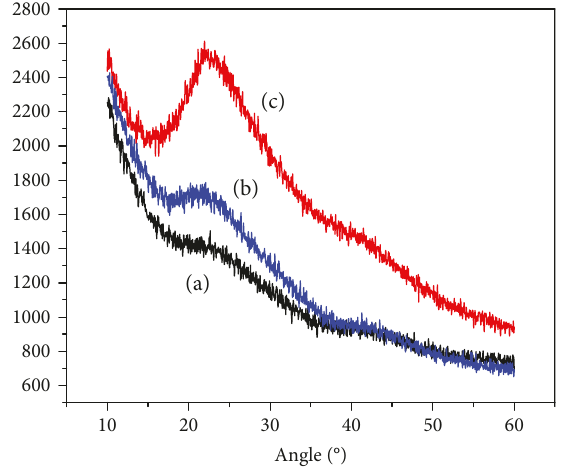
Figure 6: X-rays of HEC/PAAm xerogel (a) and HEC/PAAm xerogel with ASA incorporated by synthesis (b) and by swelling